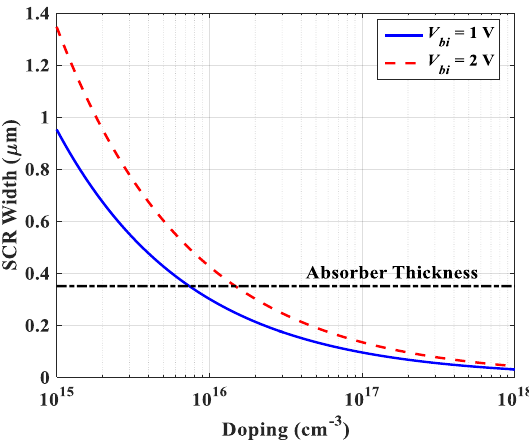
Figure 3. The variation of the depletion width vs donor or acceptor doping